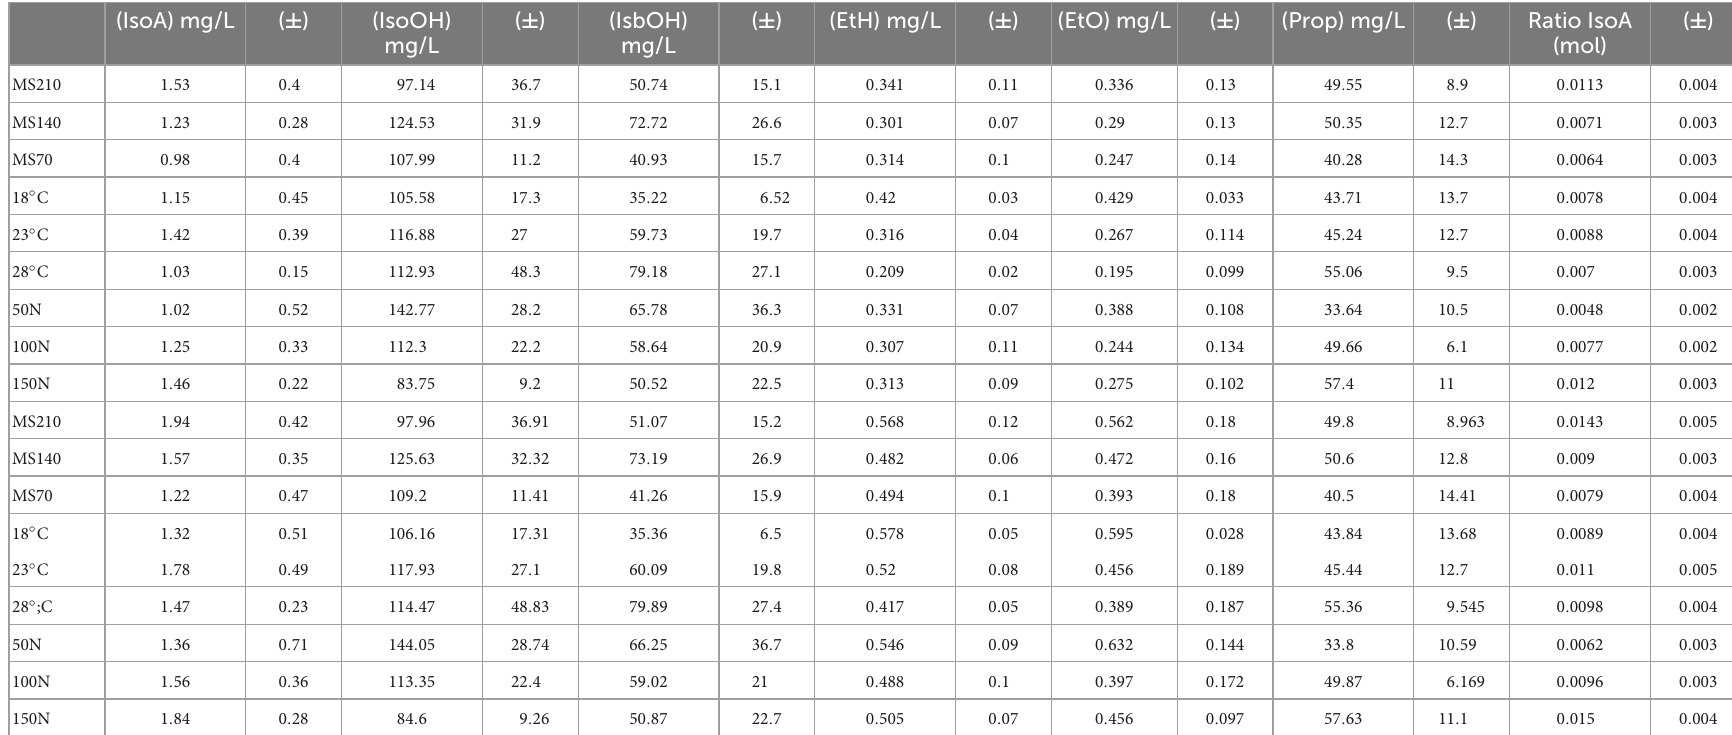
TABLE 2 Group averages (N0, Nadd and Temp) of final aroma concentrations in the liquid (top table) and for total production (bottom